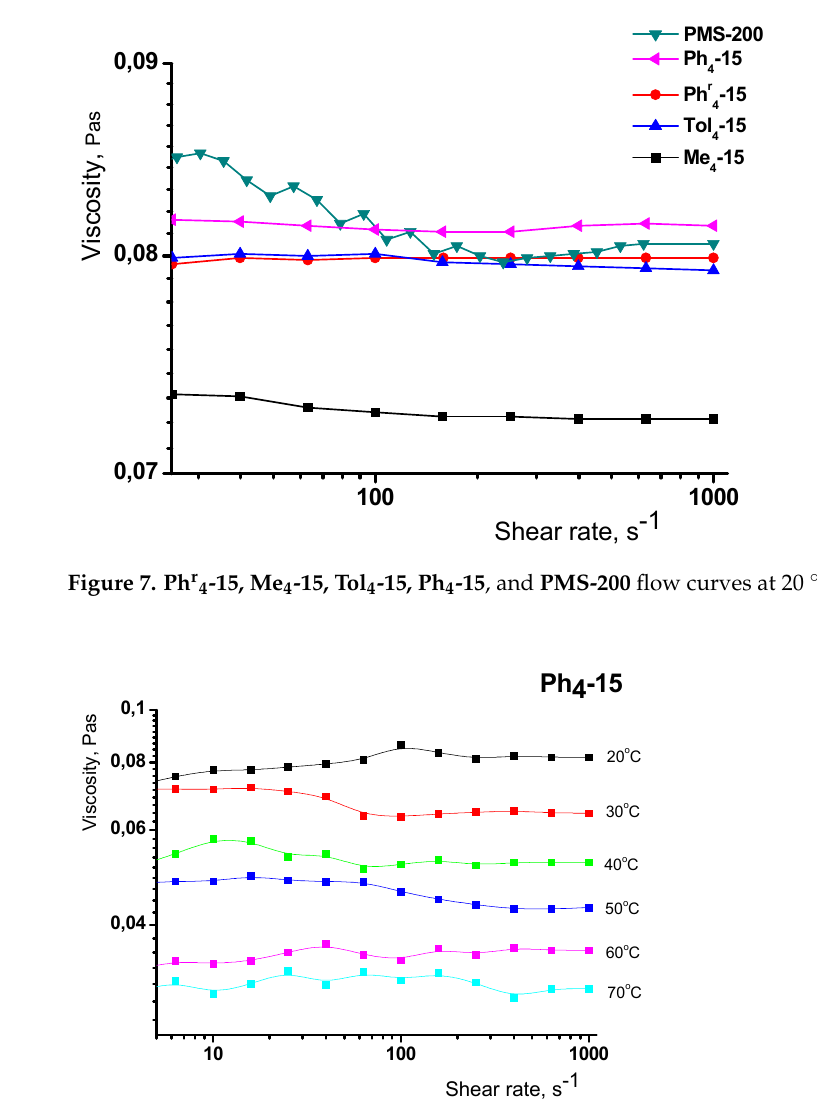
Figure 8. Flow curves of star-shaped Ph 4 -15 polymer at 20, 30, 40, 50, 60, and 70 °C. The viscosity temperature dependencies in Arrhenius equation coordinates (Figure 9) were plotted.